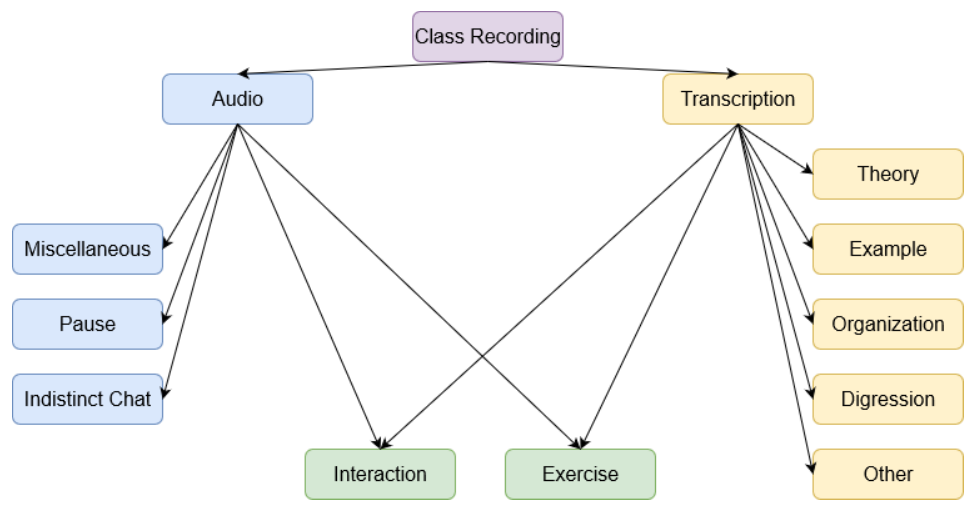
Figure 1. Hierarchy of academic